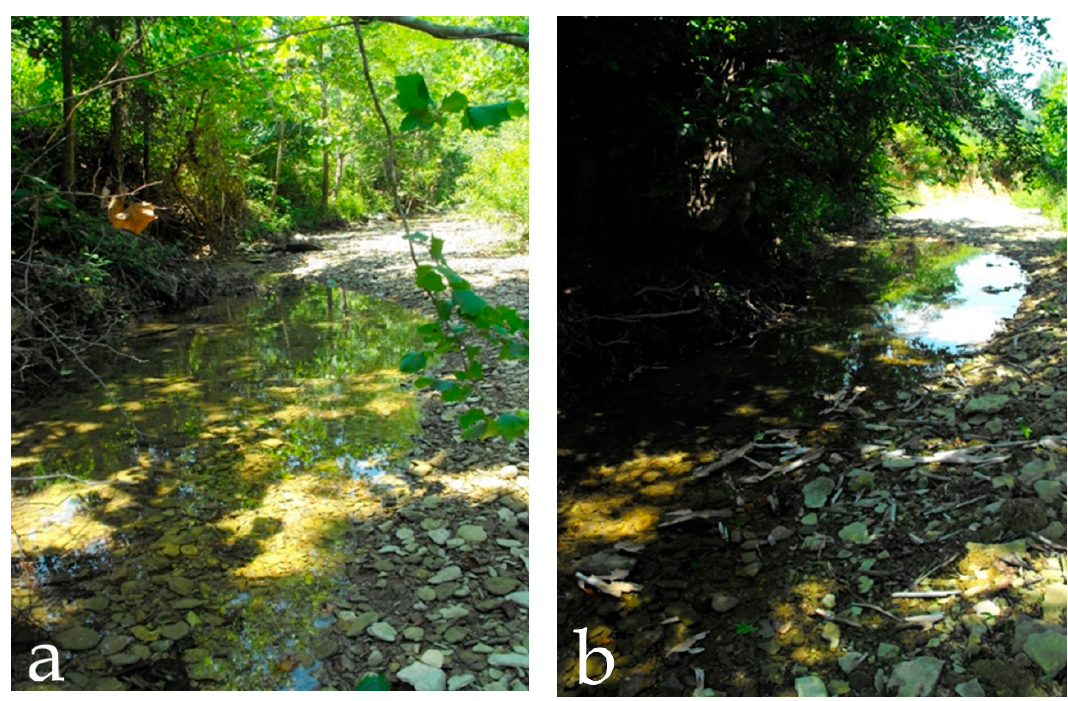
Figure 6. The sampling locations #5 ( a ) and #6 ( b ) from the Abraham Lincoln Birthplace National Historical Park in Kentucky, USA.